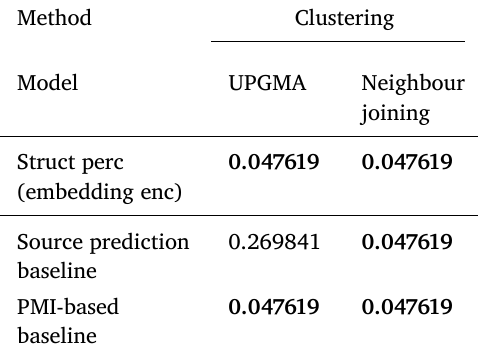
Generalized Quartet distance between trees of the Slavic language family, inferred from word prediction results using the structured perceptron model, and the Glottolog reference tree. Lower is